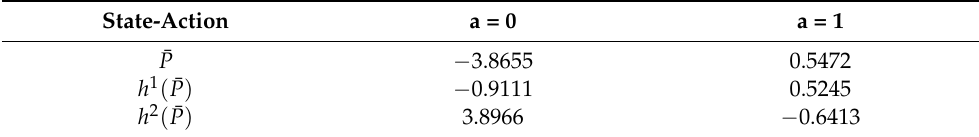
Table 2. Convergent Q -table based on SARSA from the perspective of the sensor.